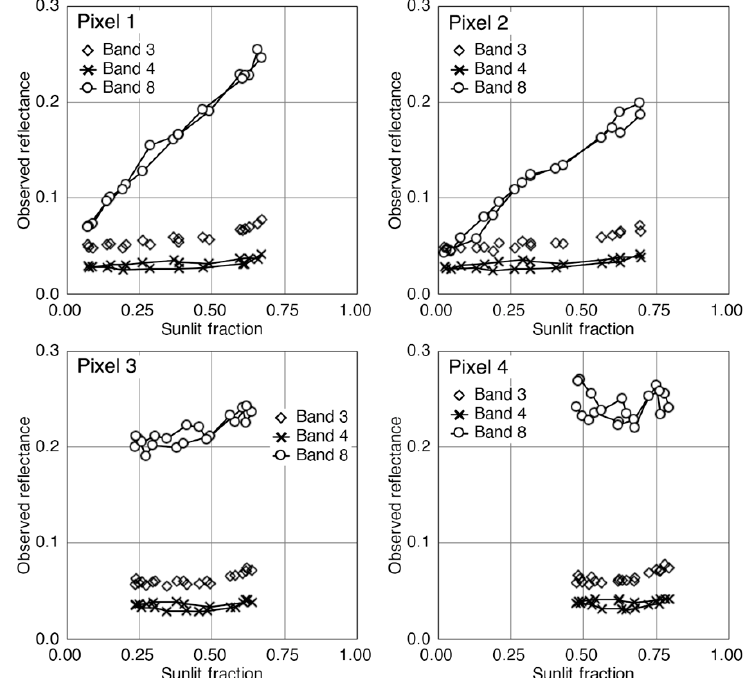
Figure 11. Seasonal relations of the sunlit fraction and observed reflectance of the pixels over four cedar tree canopies. Pixels 1 and 2 are on north-facing slopes, and 3 and 4 are on south-facing slopes. The pixel locations are shown in Figure 5b.